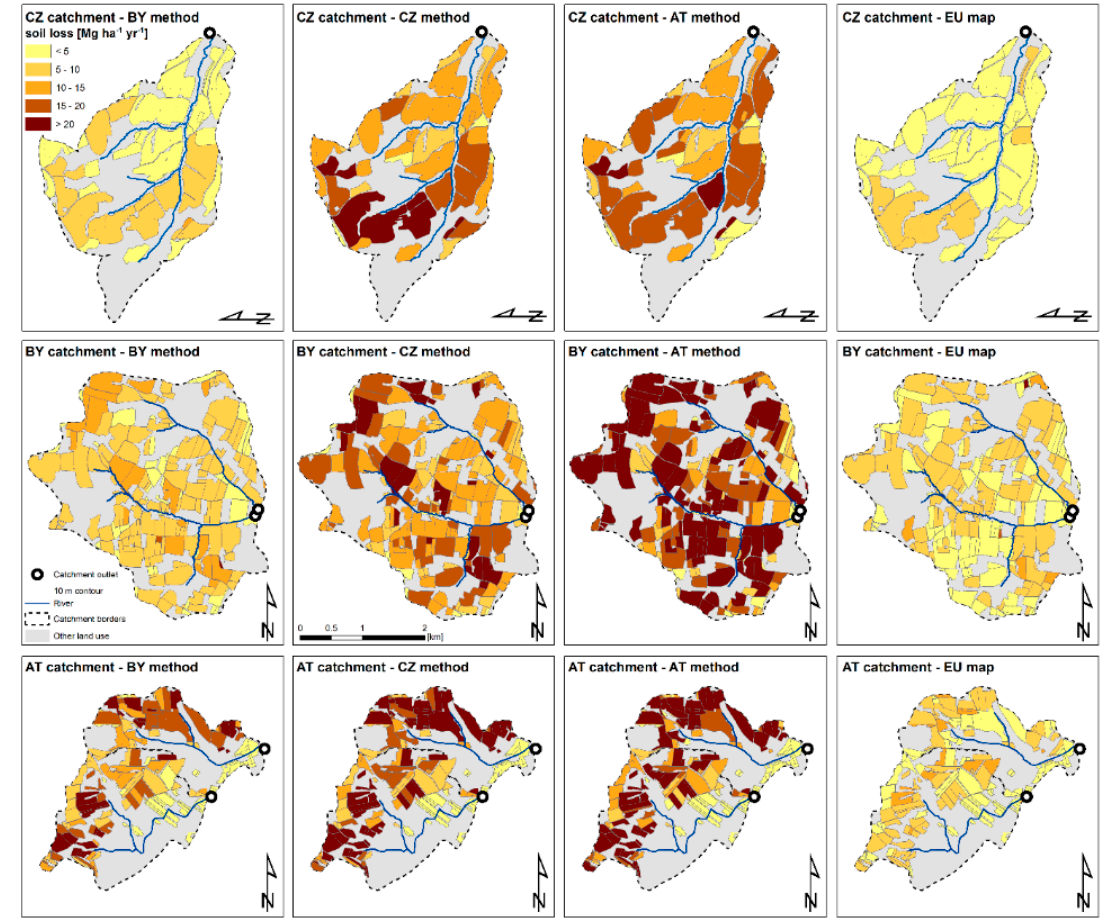
Figure 3. Modelled mean erosion per parcel for the three test catchments in Czech Republic, Bavaria, and Austria using the different standard methods applied in the respective environmental administration. Moreover, the field means based on the EU map [19] are given in the right column.